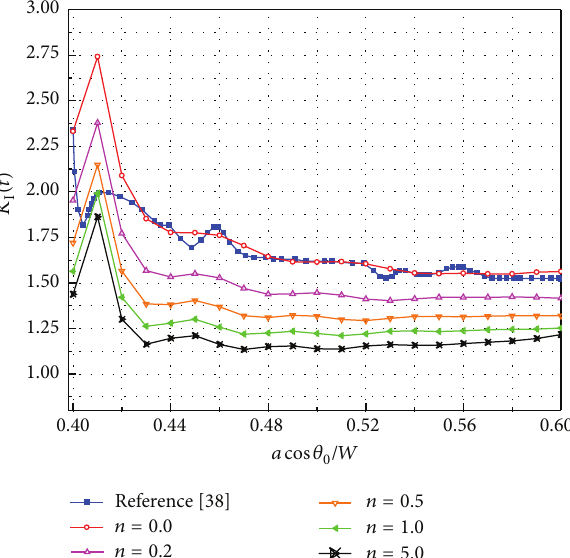
Figure 15: Normalized stress intensity factors 𝐾 I (𝑡) for propagating crack ( 𝐶 = 0.2 Cs).